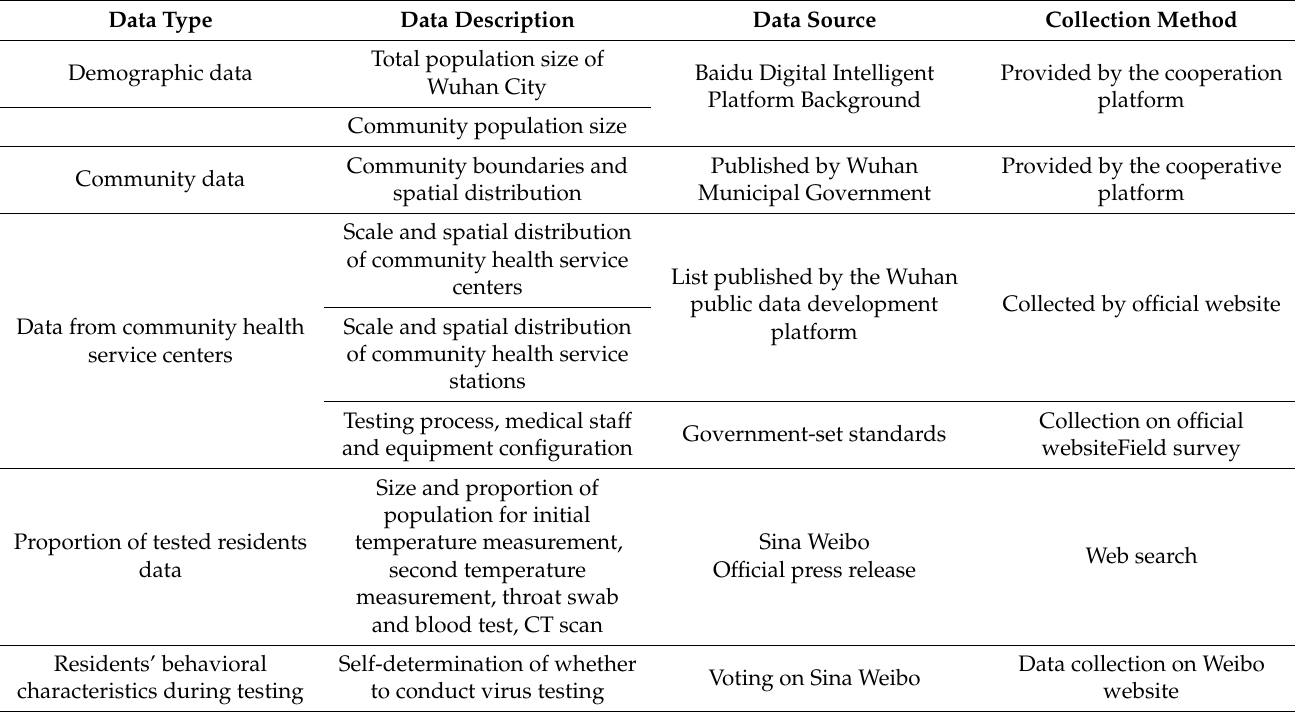
Table 1. Data types and acquisition methods during the COVID-19